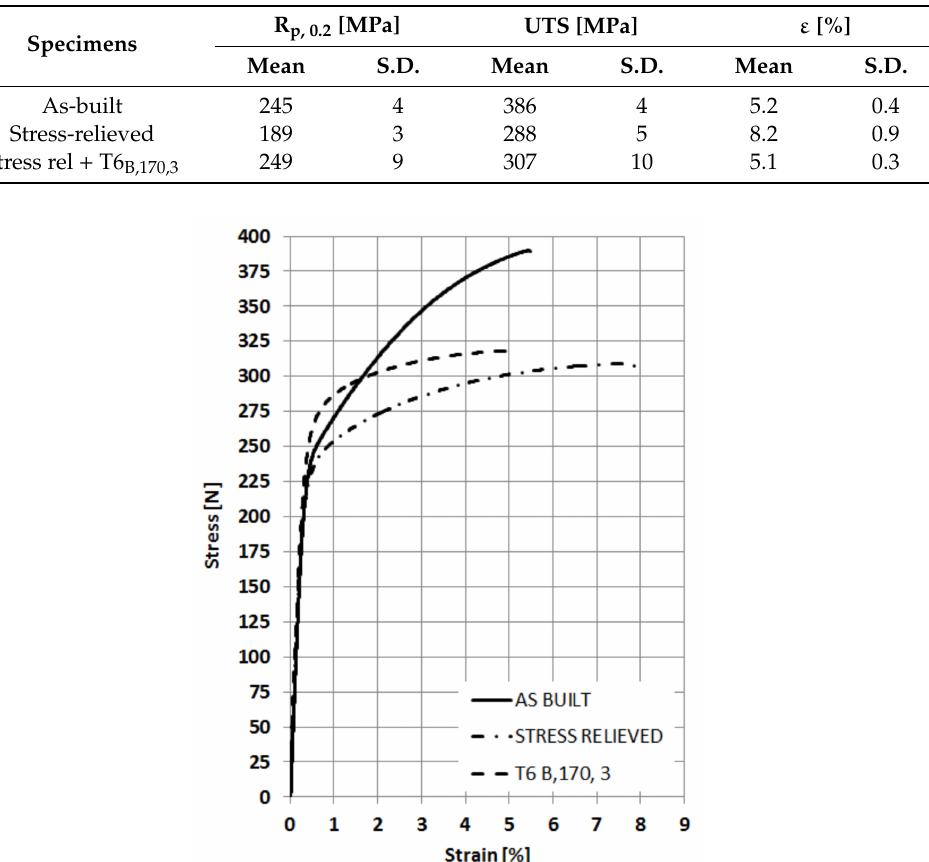
Table 4. Tensile properties of A357 specimens as-built by LPBF and after two heat treatments.